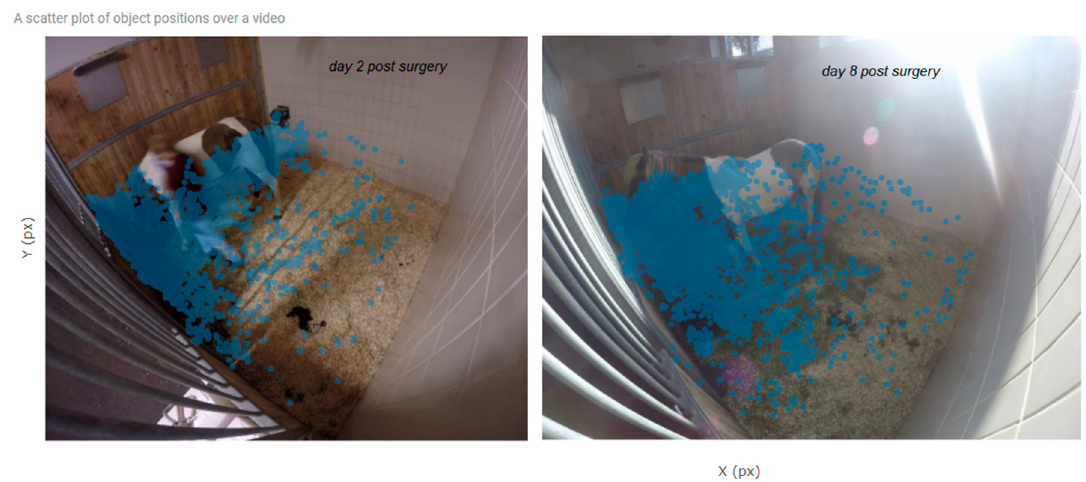
Figure 3. Position scatter plot of the horse on day 2 after colic surgery, and day 8. This plot gives additional information about the movement in the box over time in comparison to Figure 2.